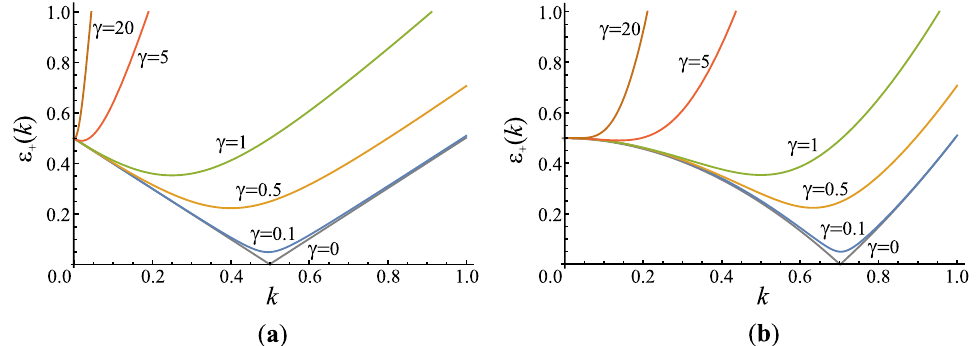
Figure 2. The energy band E + ( k ) , assuming the angular rotational symmetry, for several choices of system parameters. The other energy band is simply E − ( k ) = −E + ( k ) . In both panels, δ = 0.5, the energy gap between E + ( k ) and E − ( k ) closes for γ = 0 and remains opened for finite γ varied between values zero and 20. The other parameters are: ( a ) n = m = 1; ( b ) n = m = 2. The minimum of E + ( k ) determines the radius of the nodal ring (see Figure 1) k 0 which shrinks with increasing γ and becomes zero in the limit γ → ∞ , turning the picture of two intersecting cones (with the gap opened along the intersection) into the picture of two distant cones, which are separated “vertically” by 2 δ from each